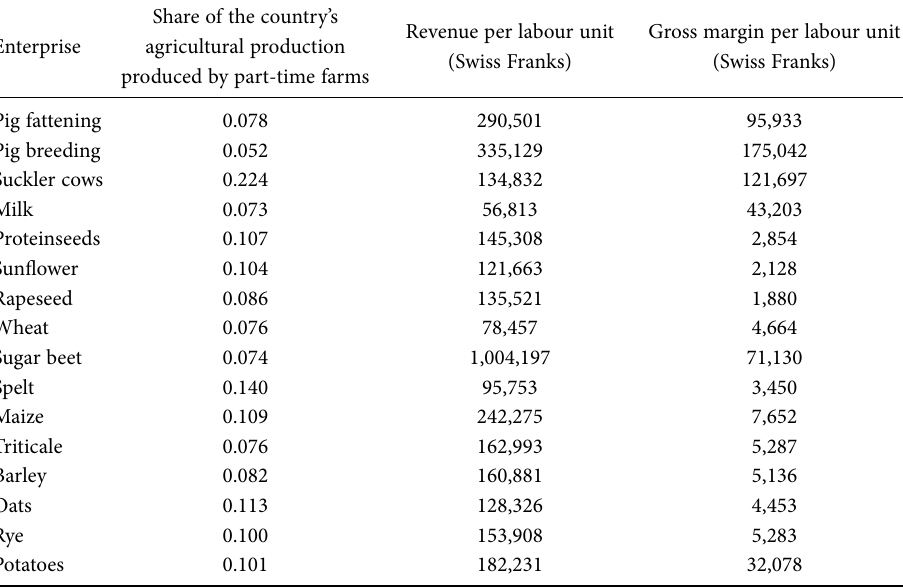
Table 2. Descriptive statistics of the aggregated data used: yearly averages per